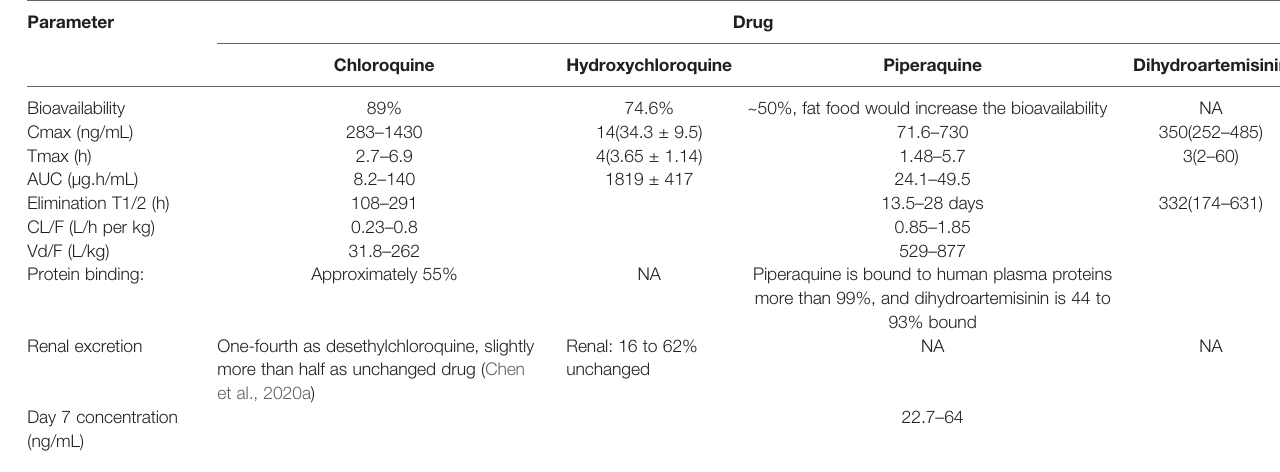
TABLE 4 | PK parameters of CQ and its